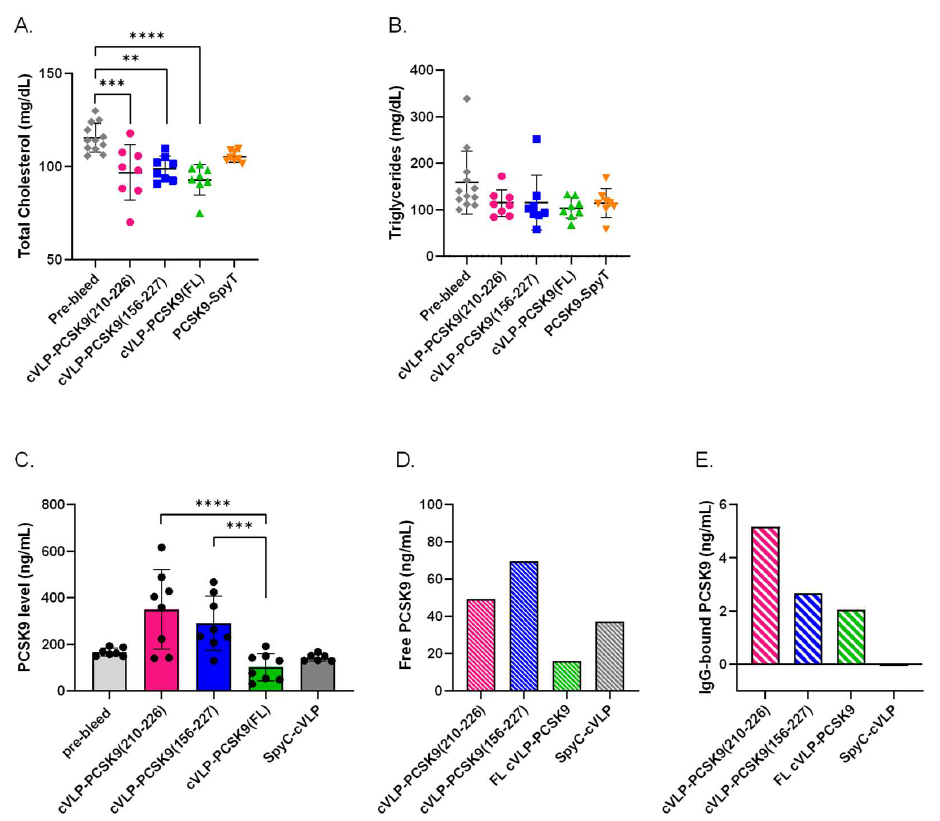
Figure 5. Biological effect of vaccine-induced antibodies. Plasma samples were obtained from groups ( n = 8) of male BALB/c mice after three immunizations (3rd bleed) with cVLP-PCSK9(210–226), cVLP-PCSK9(156–227), cVLP-PCSK9(FL), PCSK9-SpyT or SpyC-cVLP. Data are depicted as the mean ± SD. ( A ). Total cholesterol (TC) level with mean ± SD measured in plasma from mice before vaccination (i.e., pre-bleed) (116 ± 8) or after vaccination with cVLP-PCSK9(210–226) (96.9 ± 15), cVLP-PCSK9(156–227) (98.9 ± 7), cVLP-PCSK9(FL) (92.9 ± 8) or soluble PCSK9-SpyT (105 ± 3). ( B ). Triglyceride level with mean ± SD detected in plasma obtained before vaccination (pre- bleed) (159 ± 67) or after vaccination with cVLP-PCSK8210-226) (115 ± 29), cVLP-PCSK9(156–227) (115 ± 59), cVLP-PCSK9(FL) (104 ± 22) or soluble PCSK9-SpyT (114 ± 31). ( C ). Quantitative total PCSK9 levels measured in plasma before vaccination (pre-bleed) (166 ± 18) or after vaccination with cVLP-PCSK9(210–226) (350 ± 170), cVLP-PCSK9(156–227) (290 ± 116), cVLP-PCSK9(FL) (102 ± 58.4) or SpyC-cVLP (143 ± 15.7). ( D ). Quantitative free PCSK9 levels detected in run through after puri- fying IgG from pooled plasma sample obtained from mice vaccinated with cVLP-PCSK9(210–226) (49.2 ng/mL), cVLP-PCSK9(156–227) (69.6 ng/mL), cVLP-PCSK9(FL) (16.1 ng/mL) or SpyC-cVLP (37.2 ng/mL). ( E ). Quantitative PCSK9 levels detected in 10 µ g purified IgG from pooled plasma sam- ples obtained from mice vaccinated with cVLP-PCSK9(210–226) (5.2 ng/mL),